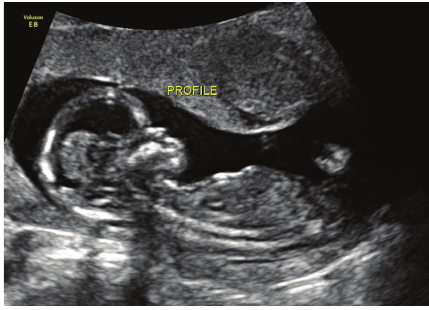
Figure1:Profileat14-weekgestationshowsprominentforeheadand nasal hypoplasia.